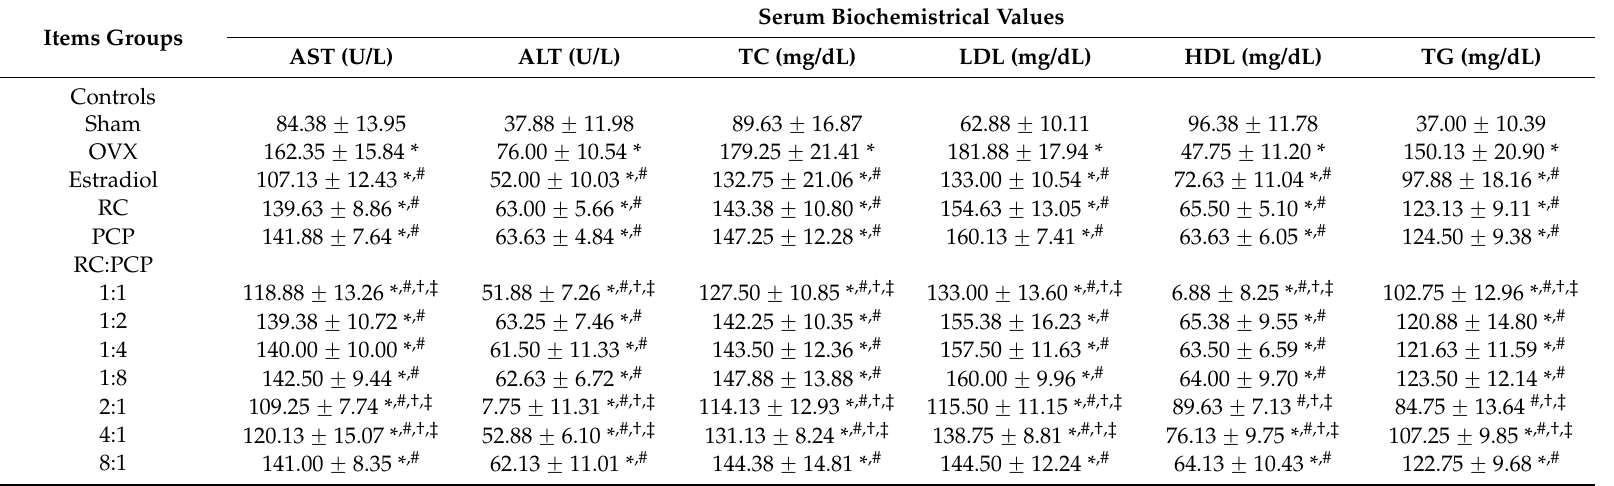
Table 9. Serum biochemistry: AST, ALT, TC, LDL, HDL and TG levels in sham-operated or OVX ddY